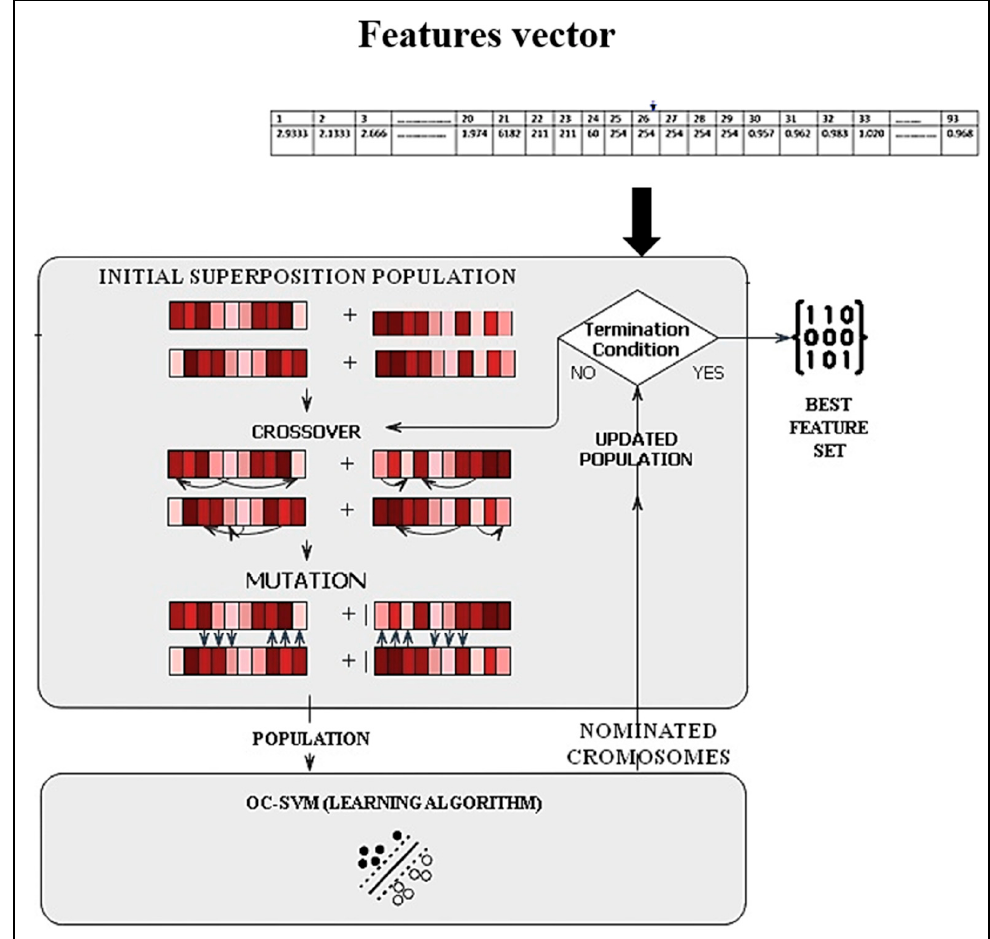
Figure 9. Flowchart of feature selection.